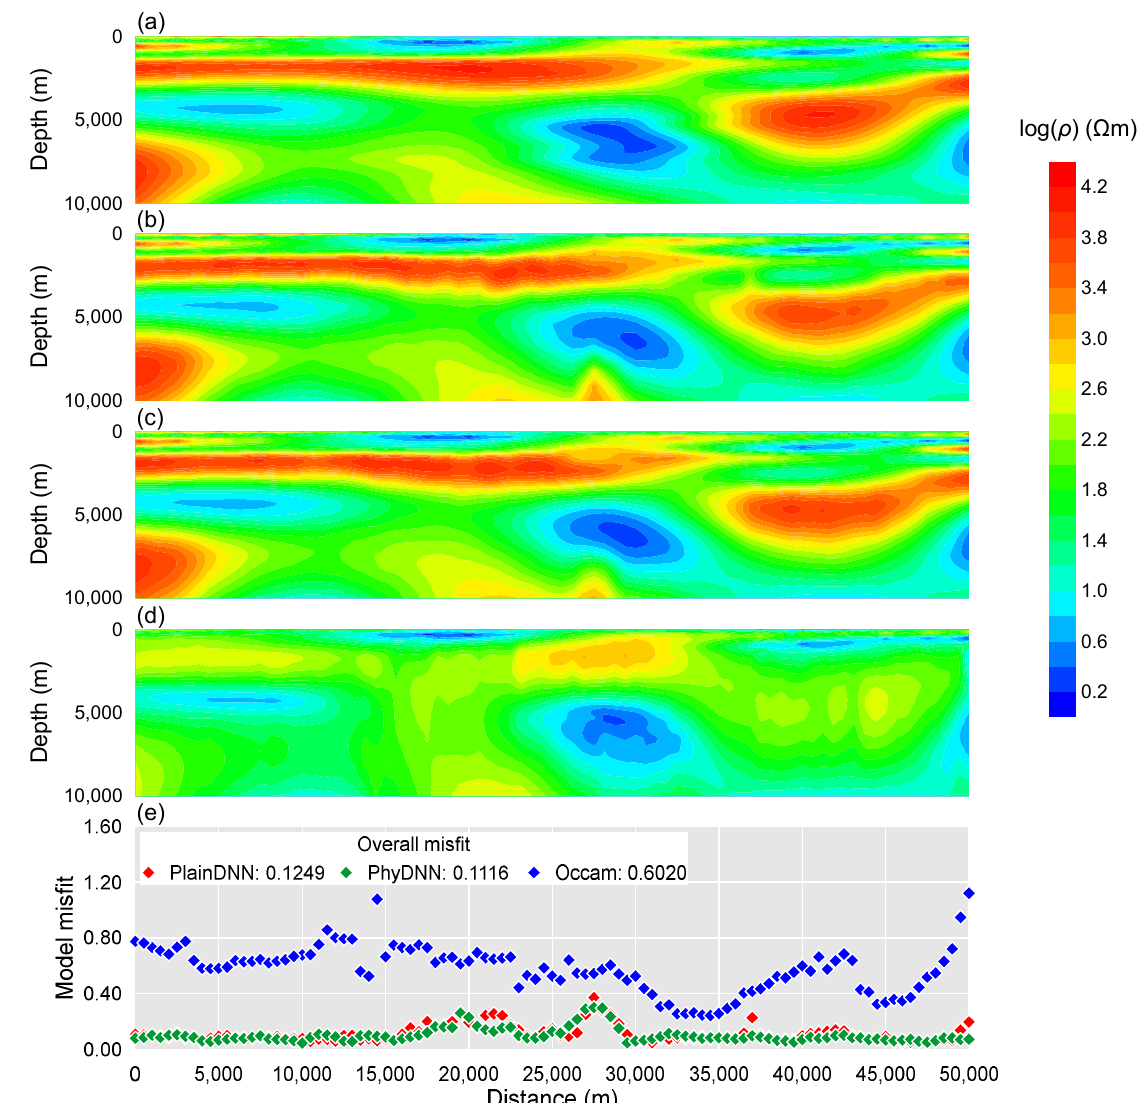
Figure 12. Comparison of the inversion results of the PlainDNN, PhyDNN and Occam methods. ( a – d ) are the true model, the recovered models of the PlainDNN, PhyDNN and Occam, respectively. ( e ) shows the individual model misfit for all sites and the overall model misfit of the whole model. To further assess the robustness and stability of the PhyDNN, the anti-noise perfor- mance of PlainDNN, PhyDNN and Occam inversion methods is evaluated using